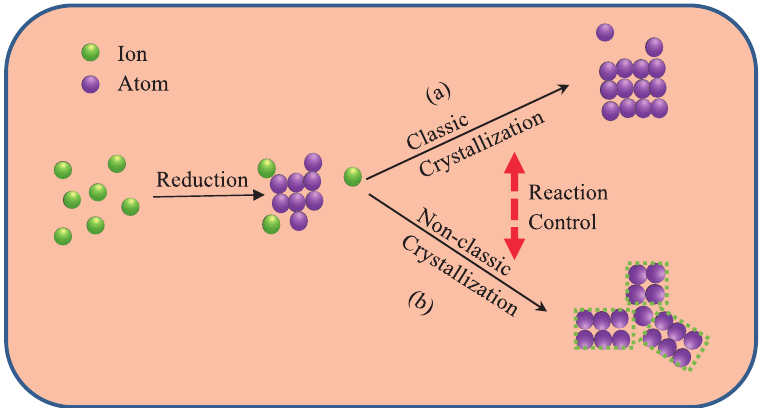
Fig. 1 An illustration of a switch of crystallization routes from the classic to the non-classic mode via reaction kinetics.